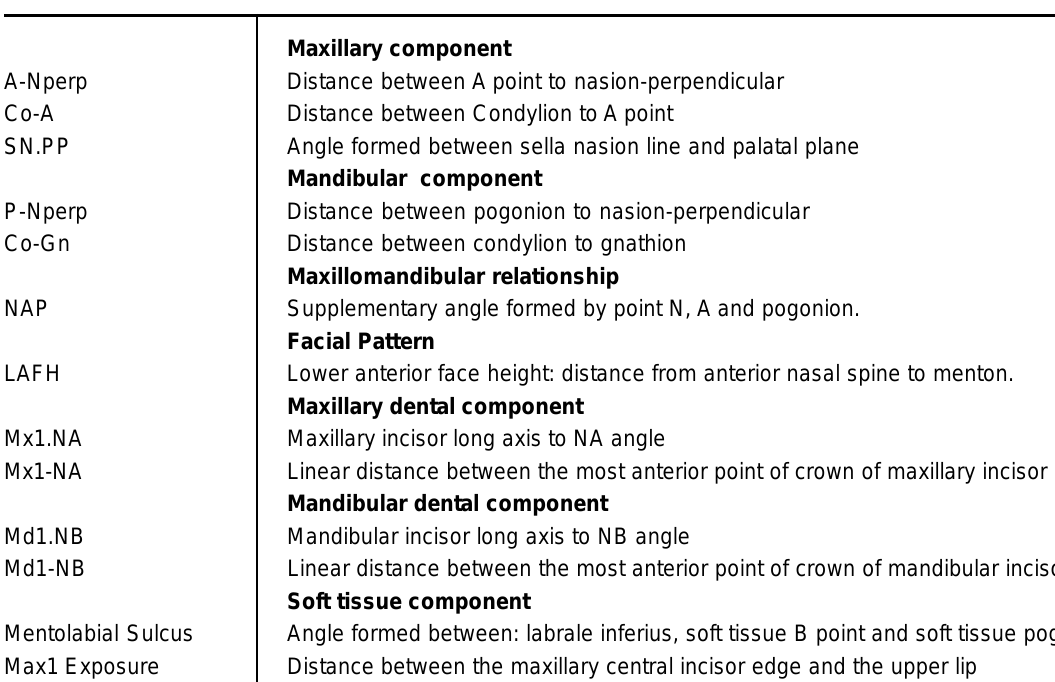
TABLE 1- Definition of unusual cephalometric